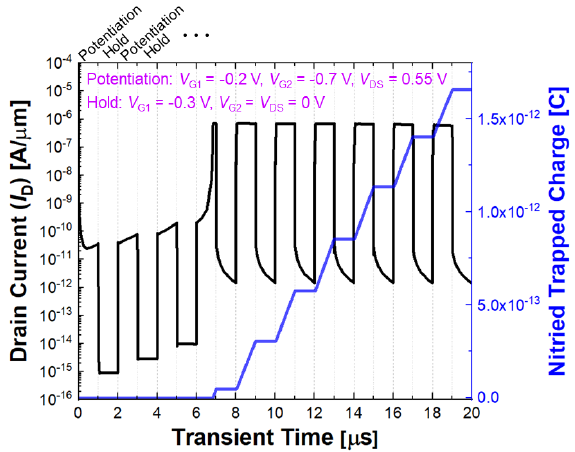
Figure 3. Drain current and nitride-trapped charges vs. learning pulses. The training pulse has a 1-μs width and a 1-μs interval.